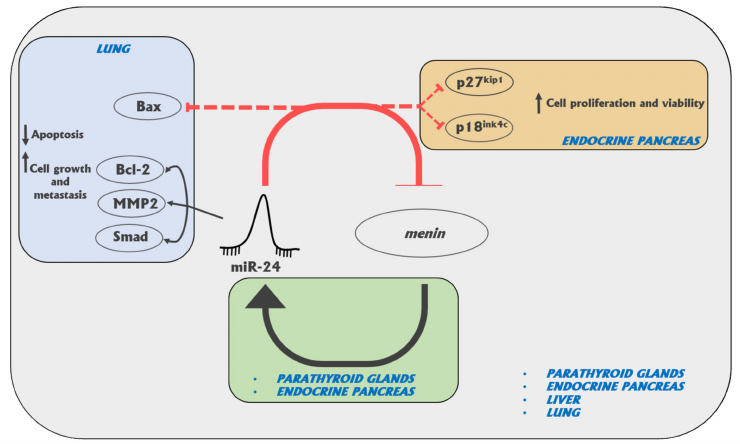
Figure 1. Diagram of the possible targets of miR-24 in canonical and non-canonical MEN1-a ff ected tissues